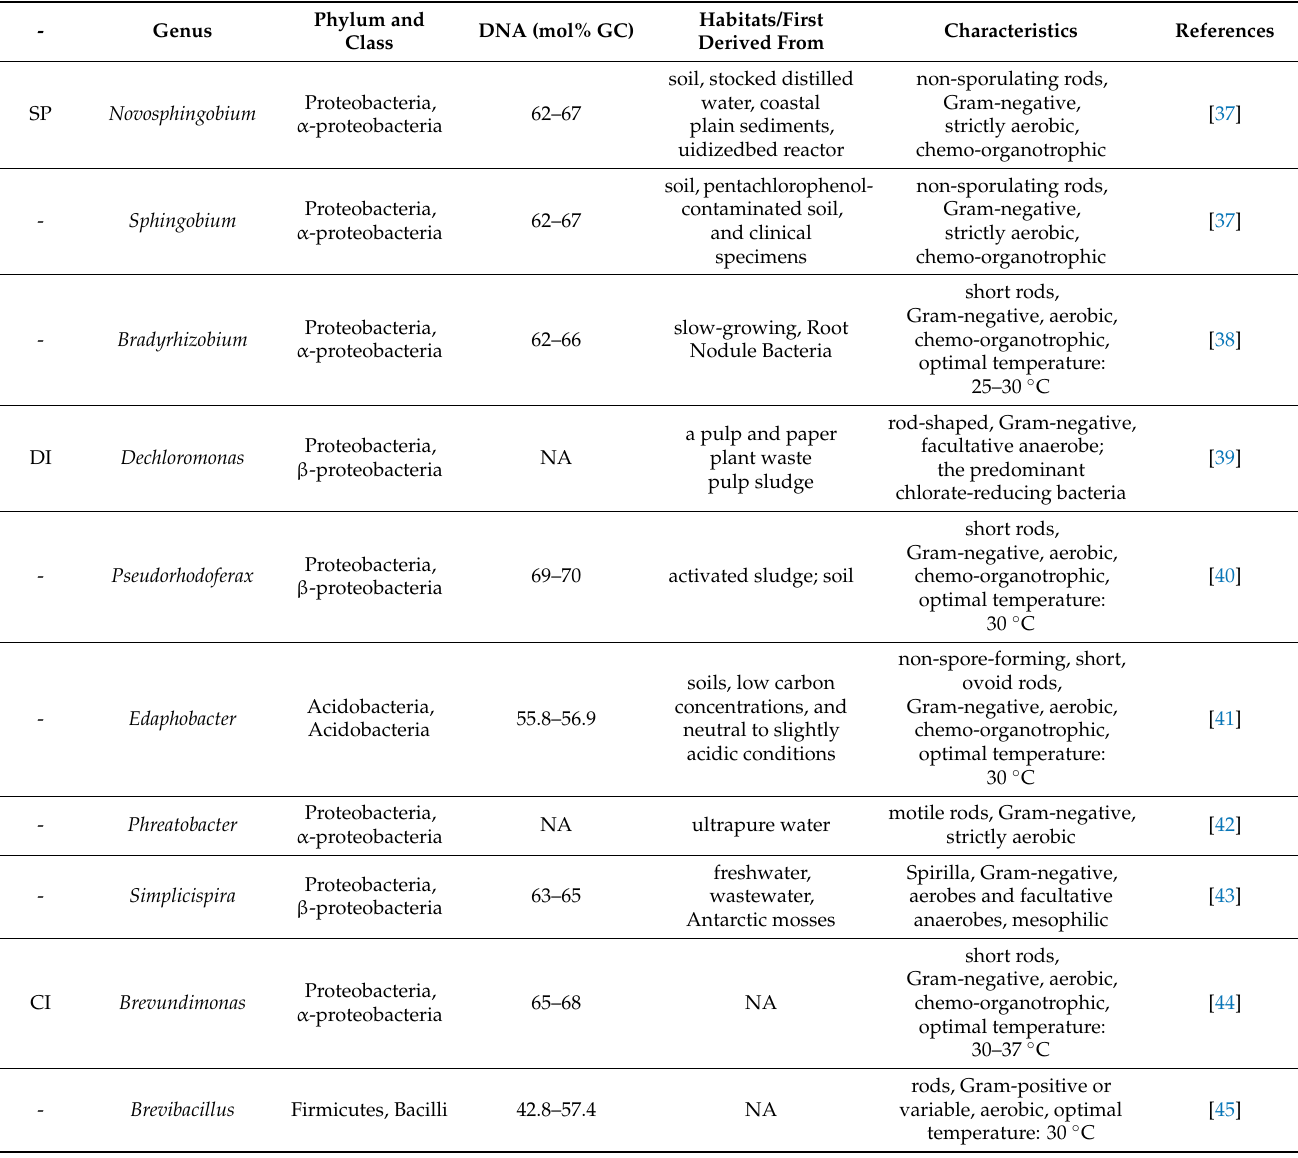
Table 4. Phenotypic, chemotaxonomic, and phylogenetic characteristics of dominant bacteria in SP, DI, and CI. NA: not